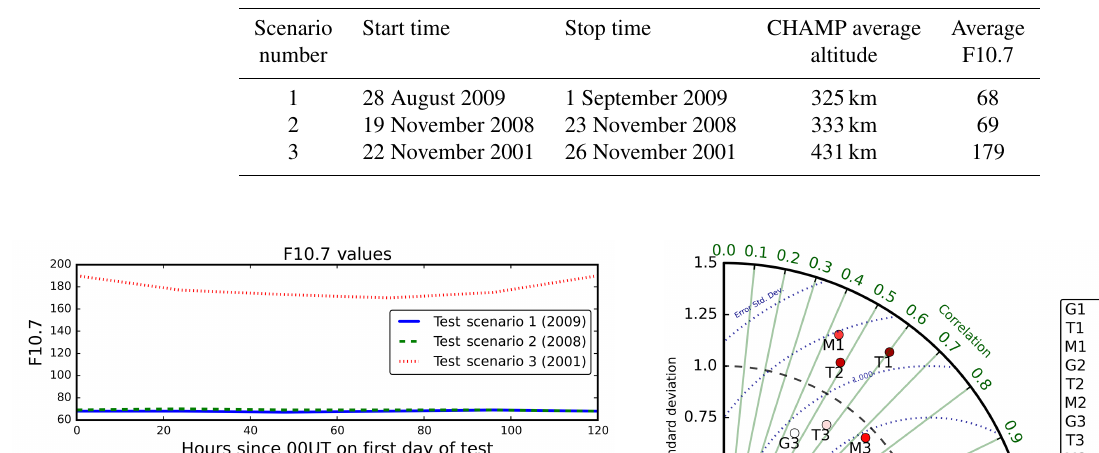
Table 1. Test scenario descriptions. The CHAMP average altitudes and average F10.7 values are taken from across the 5-day test scenarios.